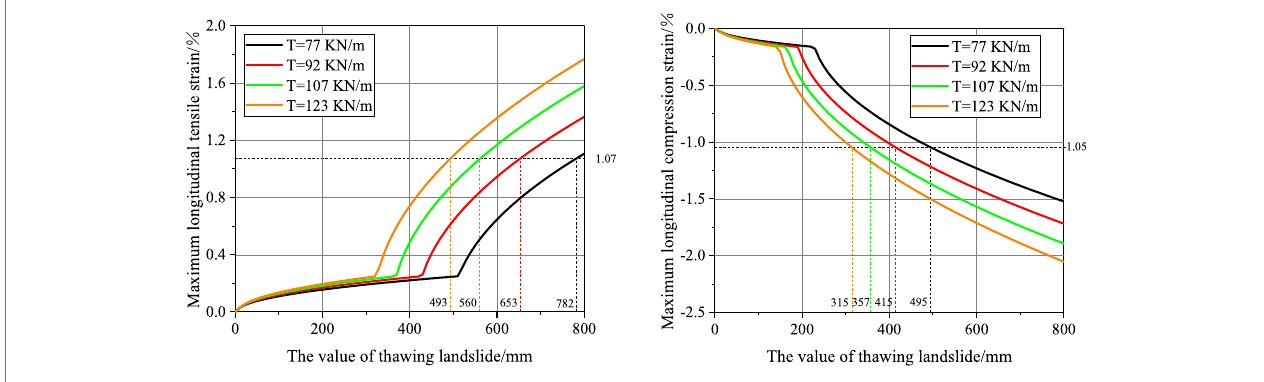
FIGURE 15 | The effect of the maximum resistance of soil on the maximum longitudinal